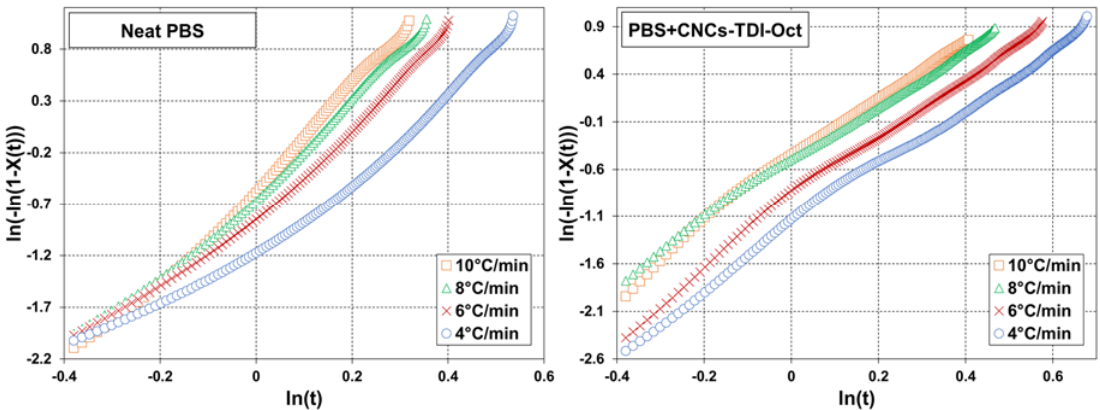
Figure 5. Avrami curves describing the crystallization of neat PBS (left) and PBS + CNCs-TDI-Oct (right) at different cooling rates. Table 3. Avrami crystallization kinetics parameters of neat and reinforced PBS at different cooling rates.